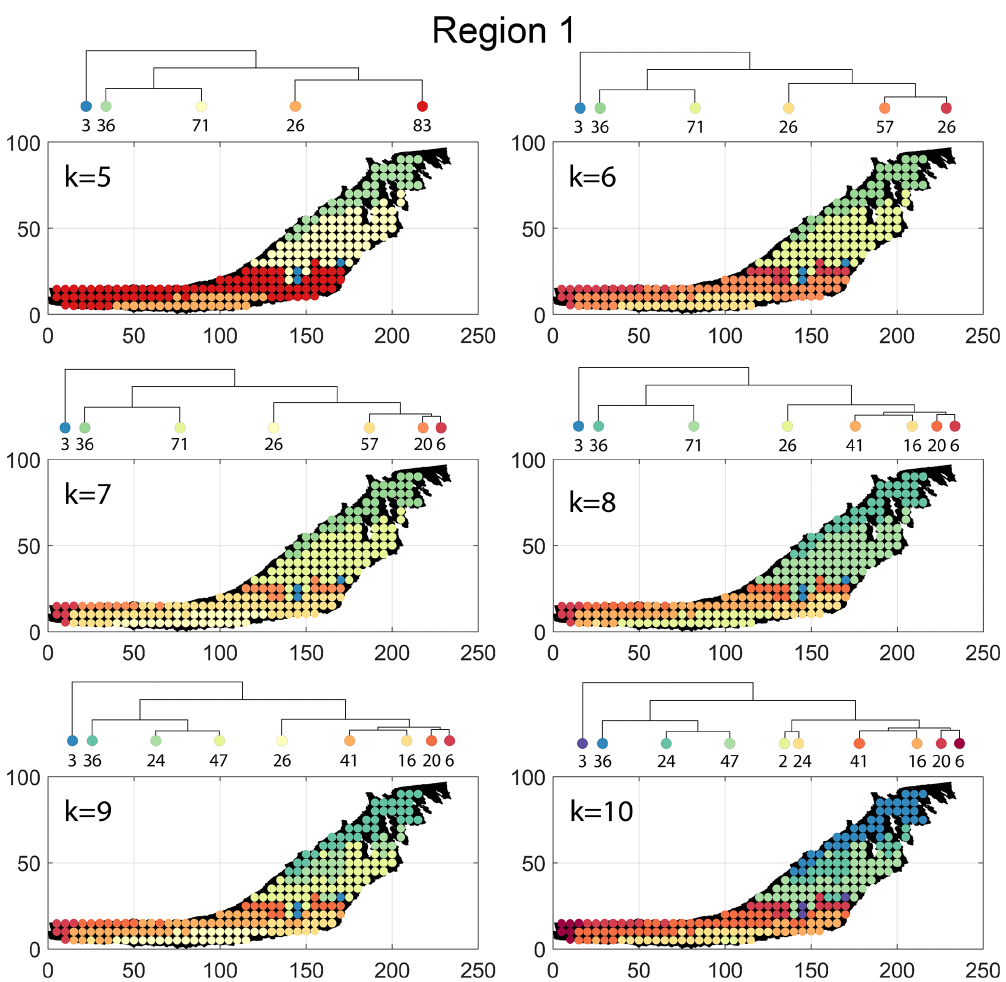
Figure B1. Variation in cluster boundaries for “ k ” clusters in Region 1 using fingerprint distance.